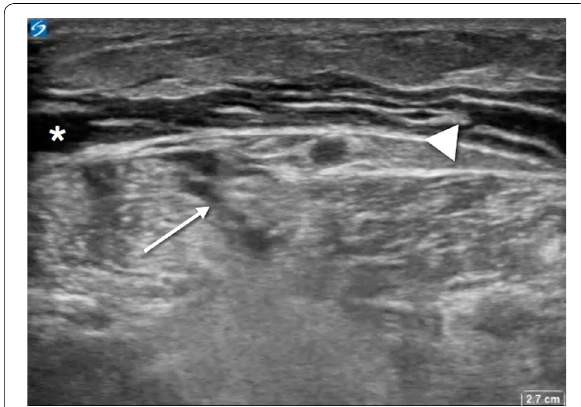
Fig. 2 Transverse view of posterior left lower extremity distal to popliteal crease. Fascia is indicated by arrowhead. Anechoic fluid collection is noted anterior to fascia (*). Deep to fascial layer, a complex fluid collection is noted (arrow) with